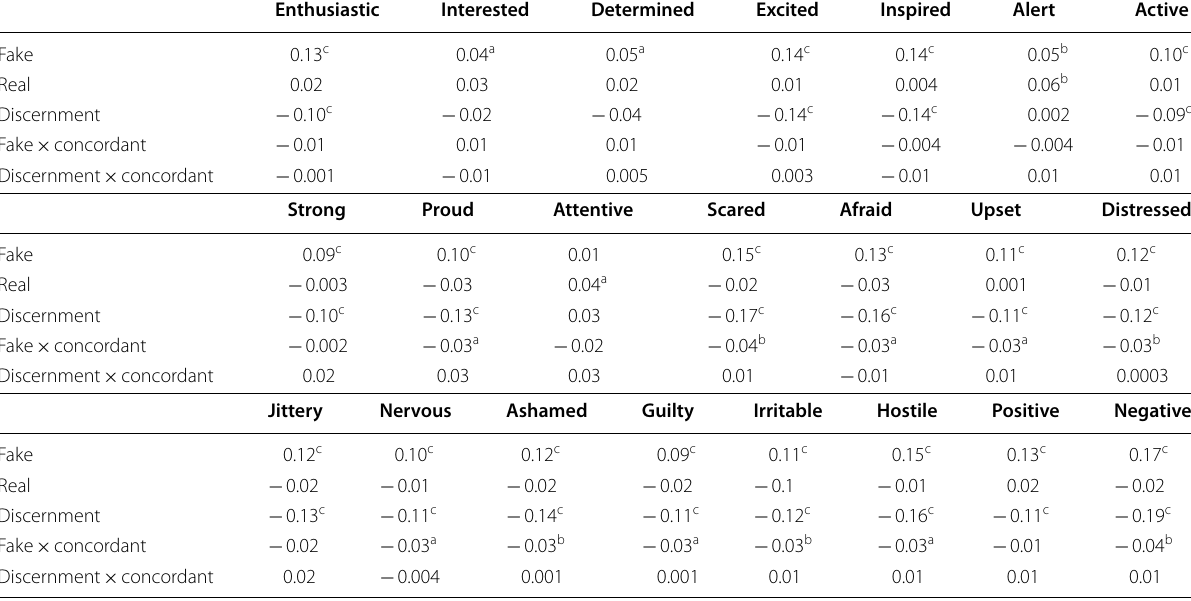
Table 2 Results of linear mixed-effects analyses for each emotion measured by the PANAS scale, plus interaction with headline political